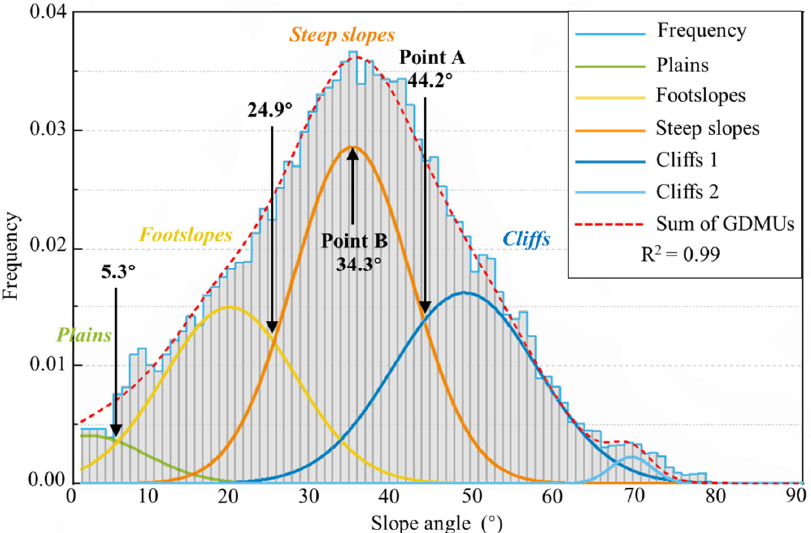
Figure 9. Results of SAD decomposition for HMA A.